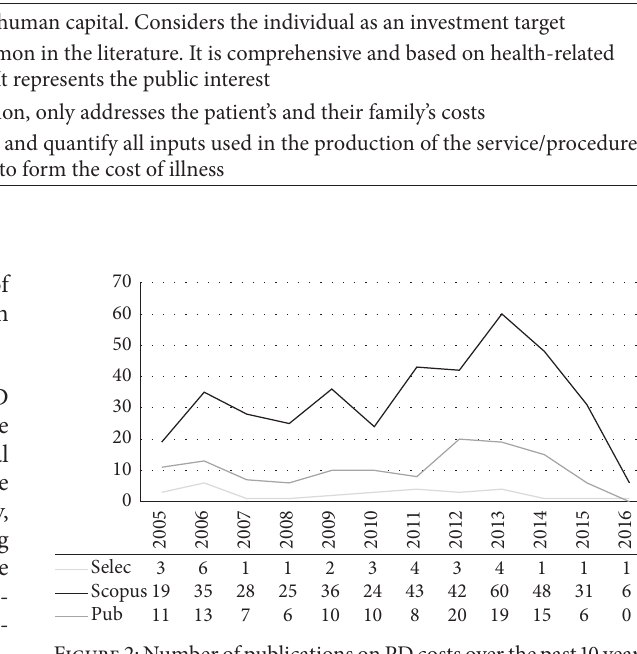
Figure 2: Number of publications on PD costs over the past 10 years. Scopus = 397 papers; Pubmed = 125 papers; Selected =